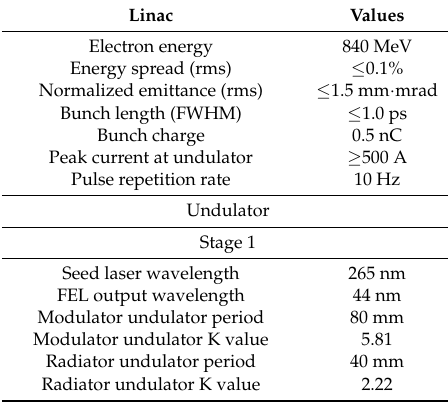
Table 1. Main parameters of the SXFEL-TF. (Reprint from reference [26])